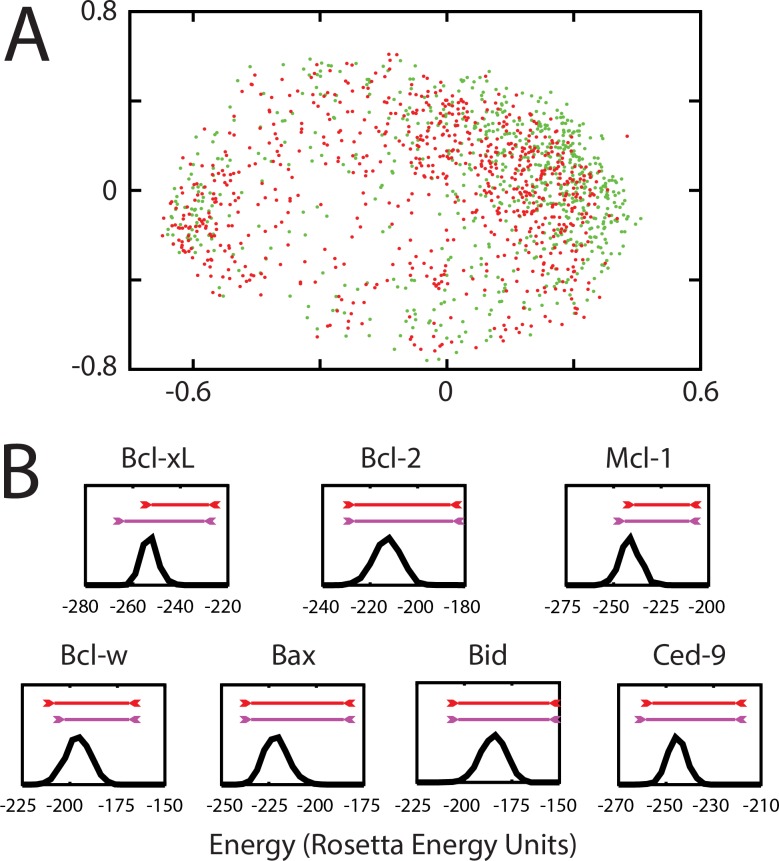
Ensembles of low-energy pocket-containing conformations.(A) To examine the effect of the particular target residues used in generating the ensemble of pocket-containing conformations, we generated separate ensembles from the top-scoring pair of target residues (Ala93 and Arg139, green) and the second-best pair (Ala93 and Ala142, red). We use exemplars to compare the similarity of surface pockets on each conformation, and we show each conformation on the two-dimensional projection that best reflects the pairwise distances between them. The overlap between the two ensembles highlights the robustness of the conformations to the particular target residues. (B) For each member of the Bcl-2 family, we generated an ensemble of conformations from unbiased simulations; the distribution of these energies is shown (black). The range of energies for pocket-containing conformations generated using a biasing potential target residues derived from the Bcl-xL protein interaction site (magenta) or the Mcl-1 protein interaction site (red) suggest that many of these conformations are energetically accessible to these proteins under physiological conditions. All energies shown here were evaluated in the absence of the biasing potential, for fair comparison. Each simulation is started from the structure of the unbound protein; a corresponding figure starting from the peptide-bound structures containing all available complexes is available as S5 Fig.